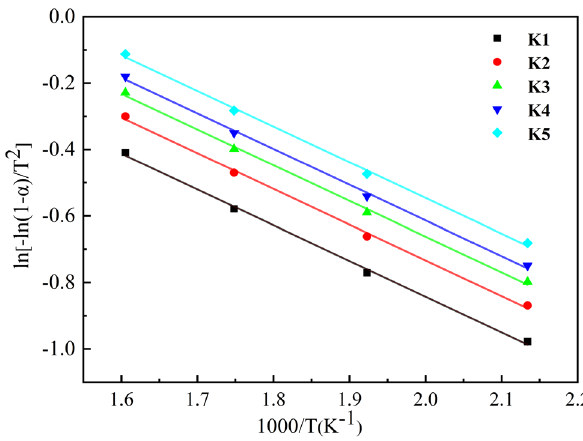
Figure 7: Coats – Redfern method plots of di ff erent samples at 20°C/min.